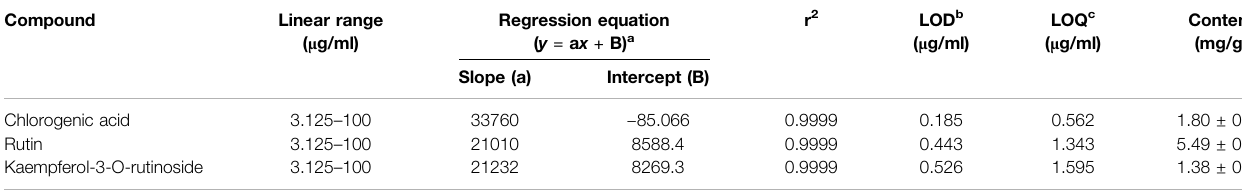
TABLE 1 | Regression equation, linearity, LOD, LOQ, and content of three compounds.